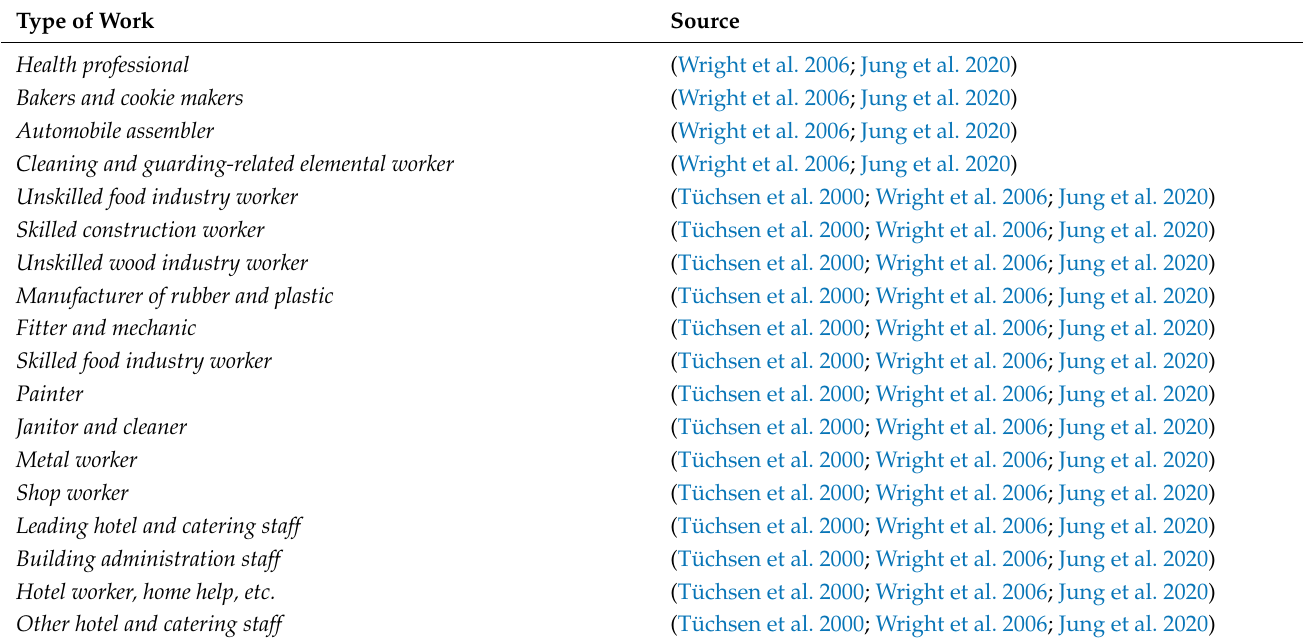
Table 5. Type of work and